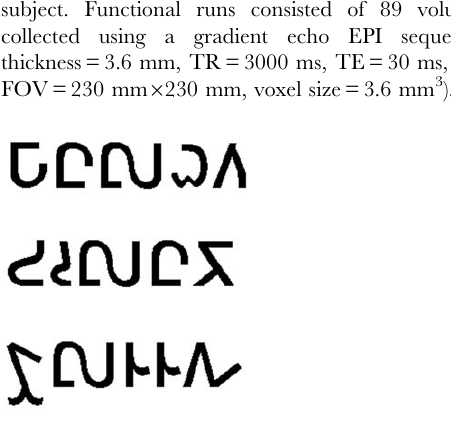
Figure 4. False fonts with tall letters (corresponds to words ‘‘stole’’, ‘‘snort’’ and